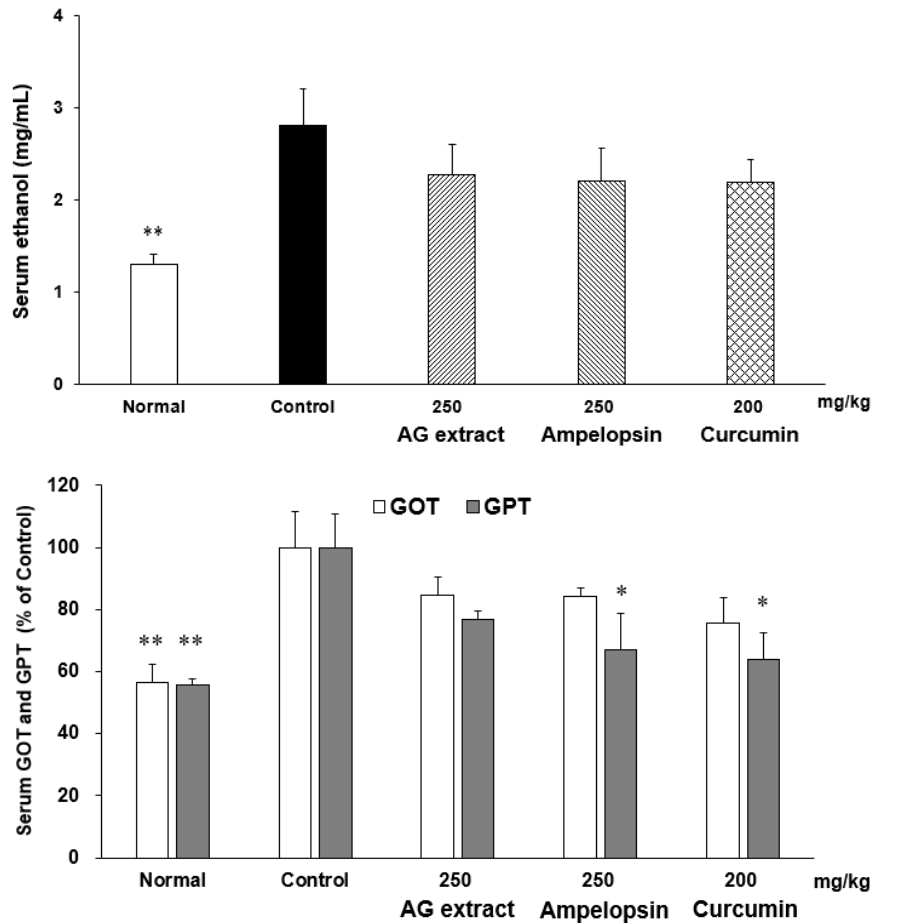
Figure 6. Effects of AG extract and ampelopsin on serum ethanol, GOT and GPT in alcohol diet-fed mice. Each column represents the mean ± SE ( n = 5–6). Data were assessed by a one-way analysis (ANOVA) of variance followed by Dunnett’s method. Asterisks denote significant differences from the control group at * p < 0.05, ** p < 0.01.